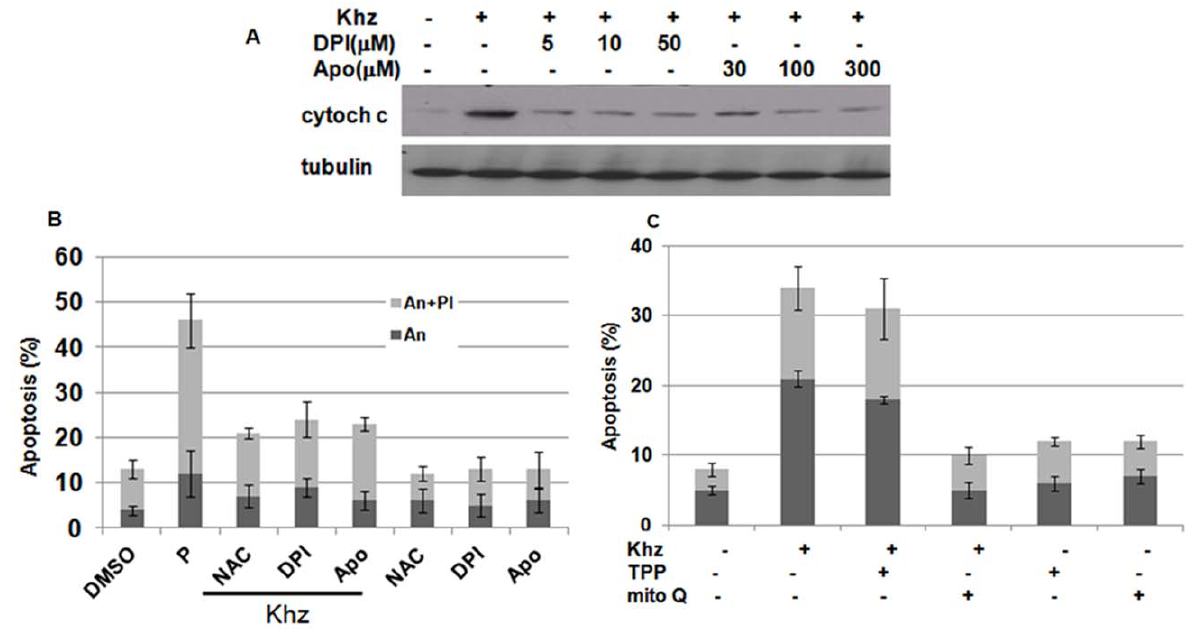
Figure 5. ROS generation by NADPH oxidase and mitochondria is required for Khz-induced apoptosis. (A) HepG2 cells were pretreated with DPI or apocynin for 1 h, and cytochrome c levels in the cytosol were analyzed 2 h after Khz treatment by immunoblot analysis. (B) Cells were pretreated with DPI (10 m M), apocynin (300 m M), or NAC (5 mM) for 30 min, and apoptosis was analyzed as in Fig. 2(C). (C) HepG2 cells were pretreated with 0.5 m M MitoQ or TPP for 30 min, and apoptosis was analyzed as in Fig.